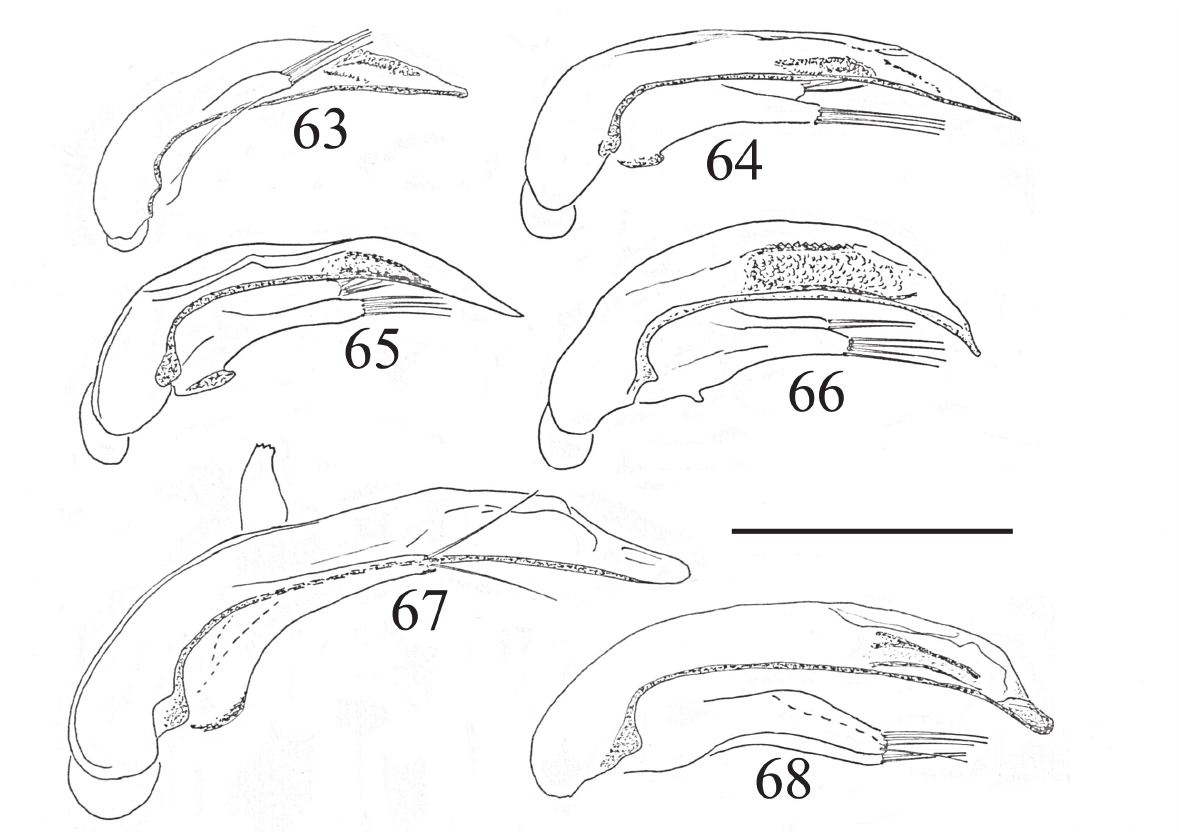
Figs 63-68. Aedeagus in lateral view of Tasmanotrechus spp.: 63) T. leai (Sloane), ♂ from Thylacine Lair; 64) T. gordoni sp. nov., HT ♂ from Heritage Landing Walk; 65) T. alticola sp. nov., HT ♂ from Cradle Plateau; 66) T. osbornianus sp. nov., HT ♂ from Lake Osborne; 67) T. moorei sp. nov., HT ♂ from Kubla Khan Cave; 68) T. rolani sp. nov., HT ♂ from Little Trimmer Cave. Scale: 0.5